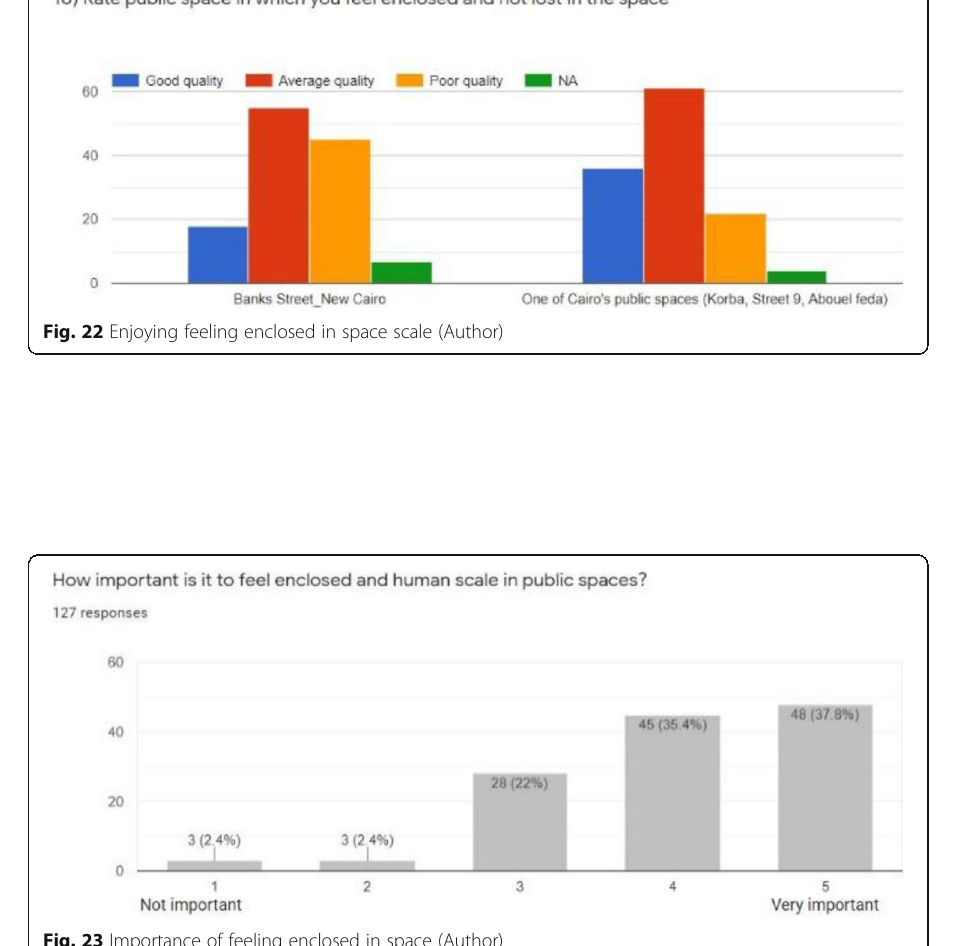
Fig. 23 Importance of feeling enclosed in space